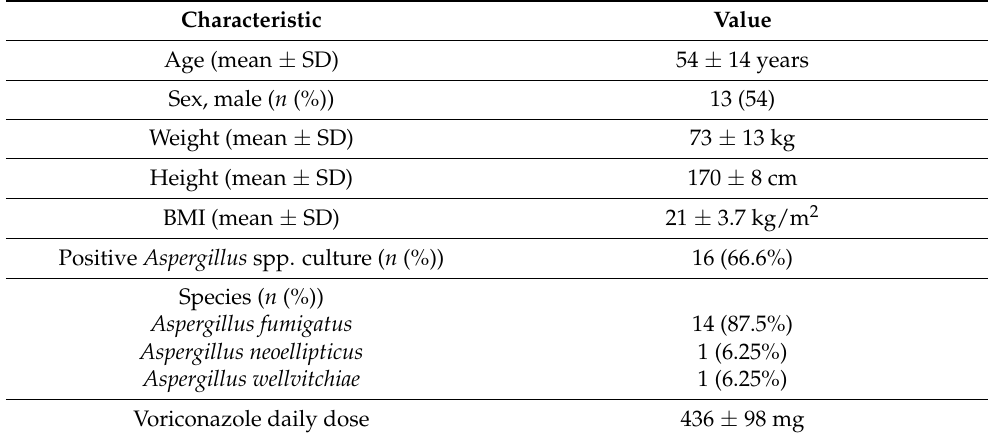
Table 1. Patient